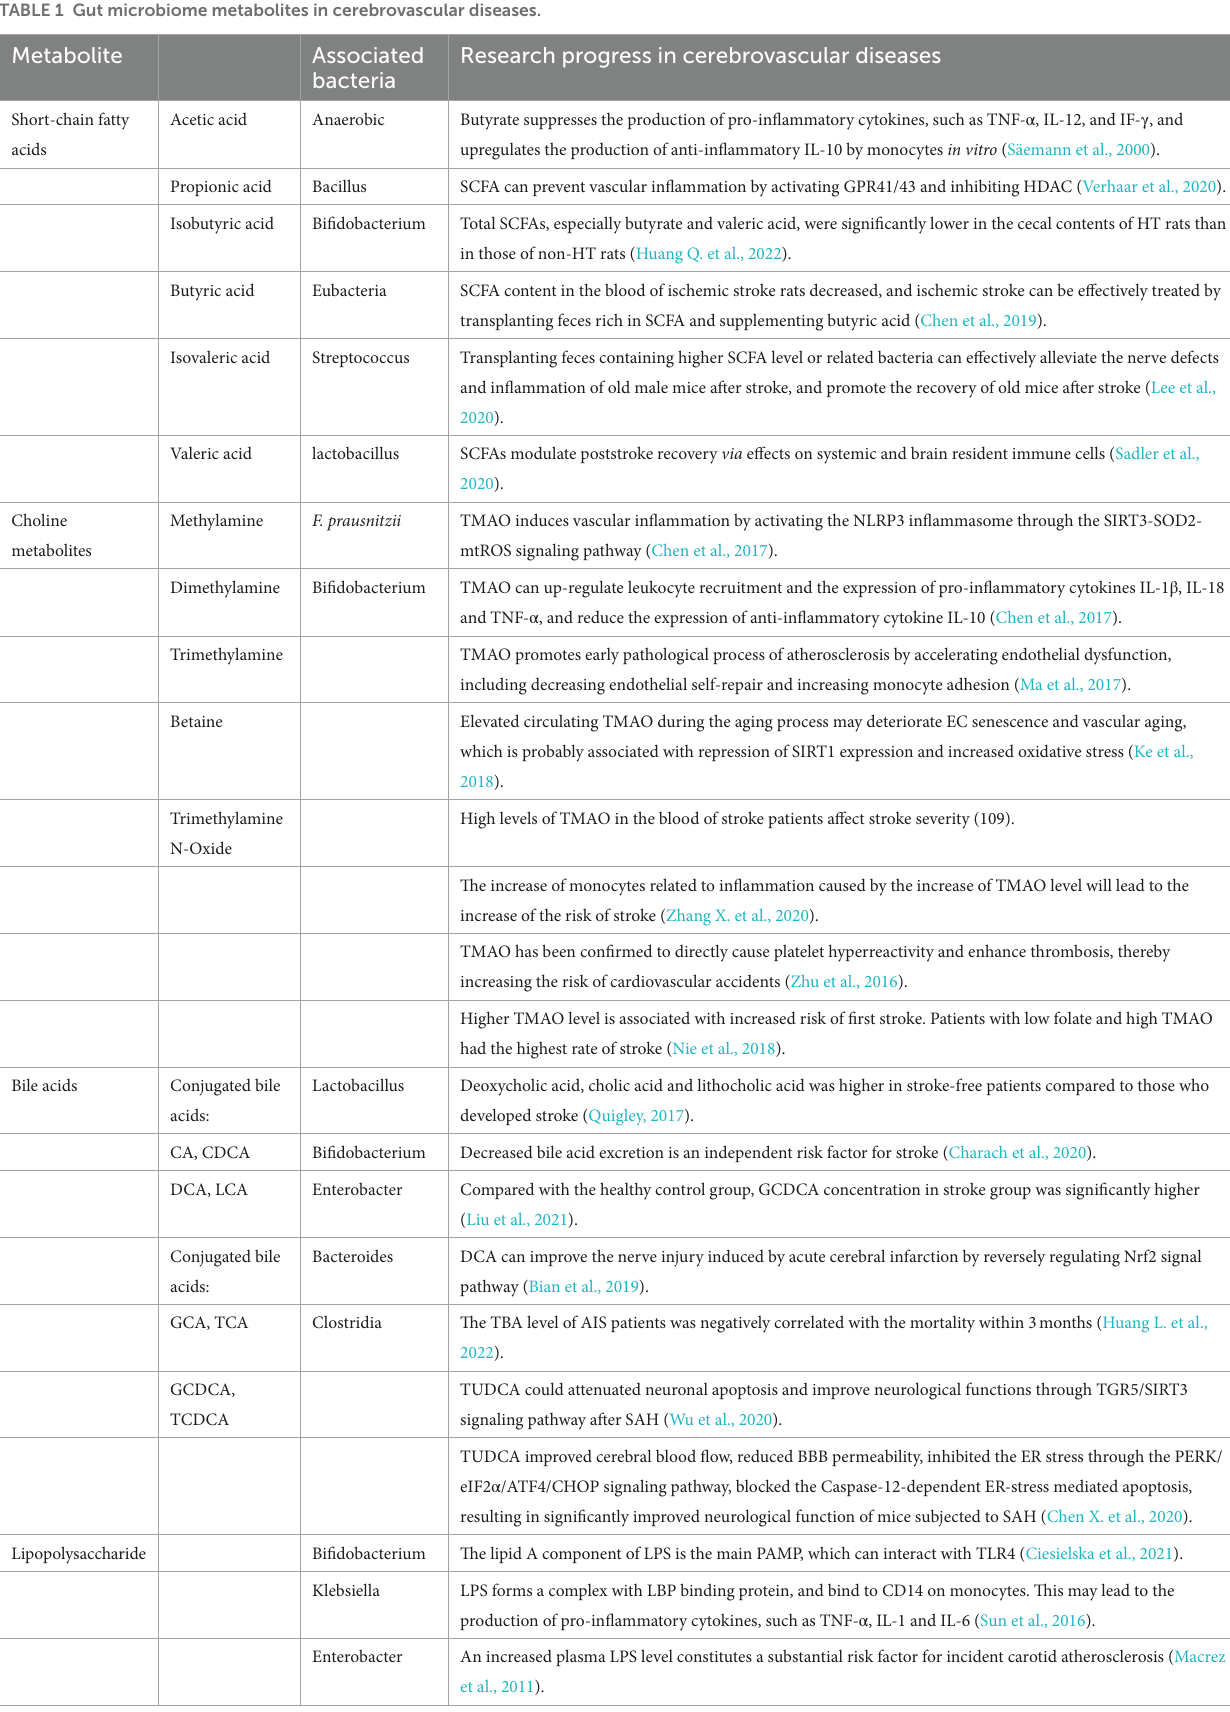
TABLE 1 Gut microbiome metabolites in cerebrovascular